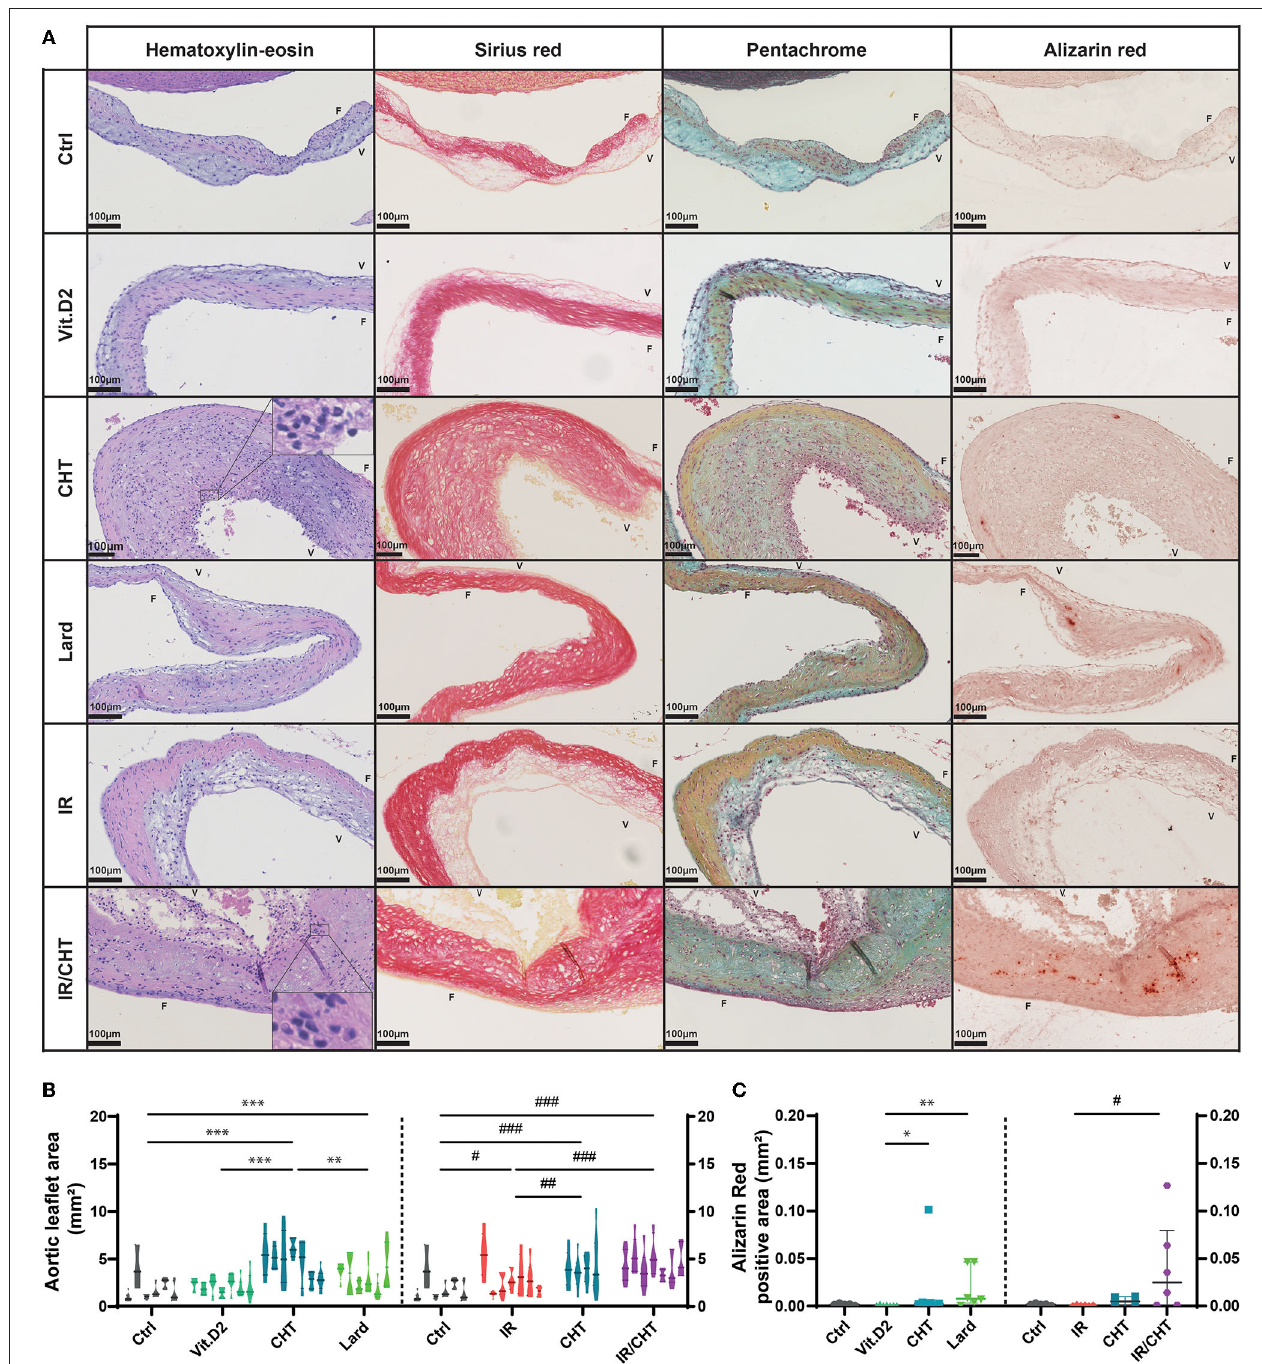
FIGURE 2 | Effect of lard- and cholesterol-enriched diets on the aortic valve leaflet histology. (A) Representative pictures of aortic valve leaflet sections stained with hematoxylin-eosin, sirius red, Movat’s pentachrome, and alizarin red per rabbit group as indicated. Magnified areas depict neutrophil infiltrates in valvular ventricularis. Scale bars = 100 µ m. (B) Violin plots represent aortic valve leaflet area measured on hematoxylin-eosin-stained aortic valve sections (each violin box represents one rabbit, 4–8 slides per rabbit). Four-group comparisons were performed by using a nested-GLM model and post-hoc SIDAK test on log-transformed data. (C) The graph represents the positive area for Alizarin Red staining on the aortic valve sections. Data are presented as medians with P25-P75 interquartiles. Four-group comparisons were performed by ANOVA and post-hoc Dunnett’s test on log-transformed data (Left: Ctrl, n = 5; Vit.D2, n = 7; CHT, n = 7; Lard, n = 6; Right: Ctrl, n = 5; IR, n = 6; CHT, n = 4; IR/CHT, n = 6). * P ≤ 0.05; ** P ≤ 0.01; *** P ≤ 0.001; # P ≤ 0.05; ## P ≤ 0.01; ### P ≤ 0.001. F, indicates fibrosa side; V, indicates ventricular side.